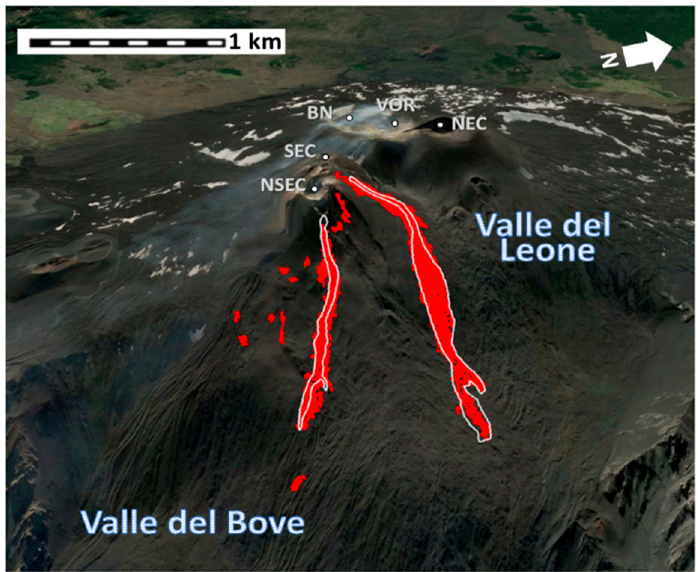
Figure 6. Lava flow map resulting from the BNN and the post-processing stages (red) and the contour of the real lava flow (white) observed during the Etna eruption occurred in August 2018. The northern flow is the one emitted on 24 August, while the southern one was erupted on 27 August.